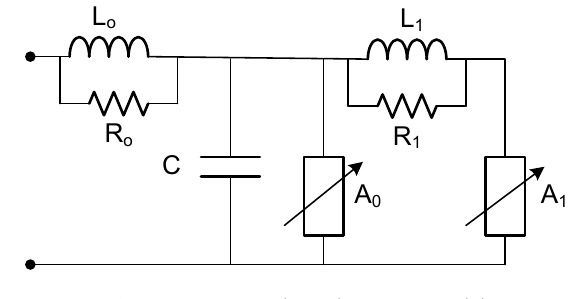
Fig. 1. Frequency-dependent IEEE